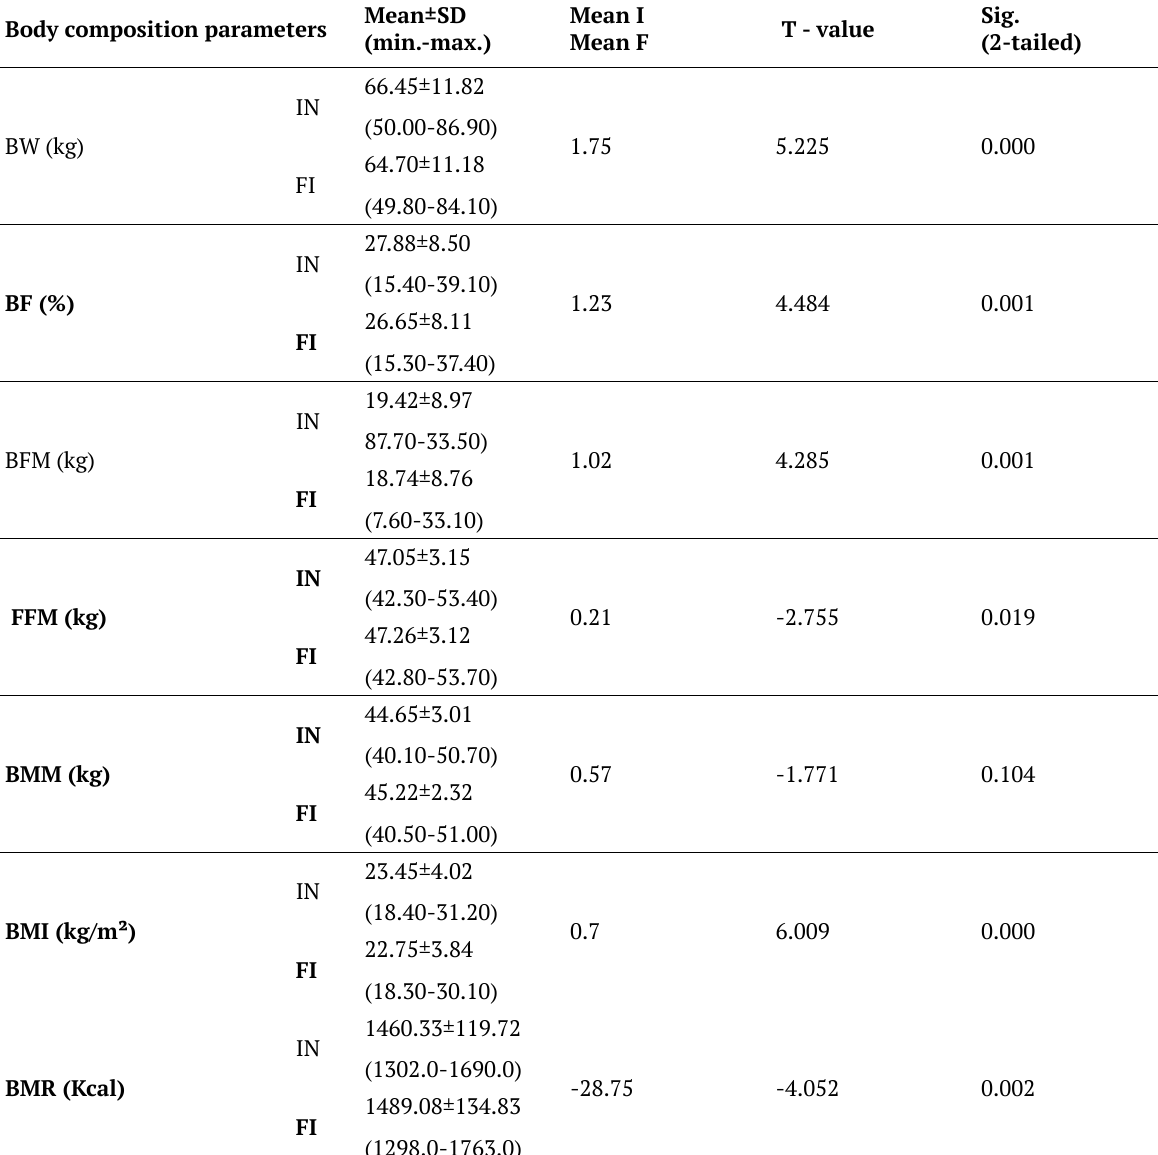
Table 2. Differences between the initial and final measurements BC after the three-month cardio program Body composition